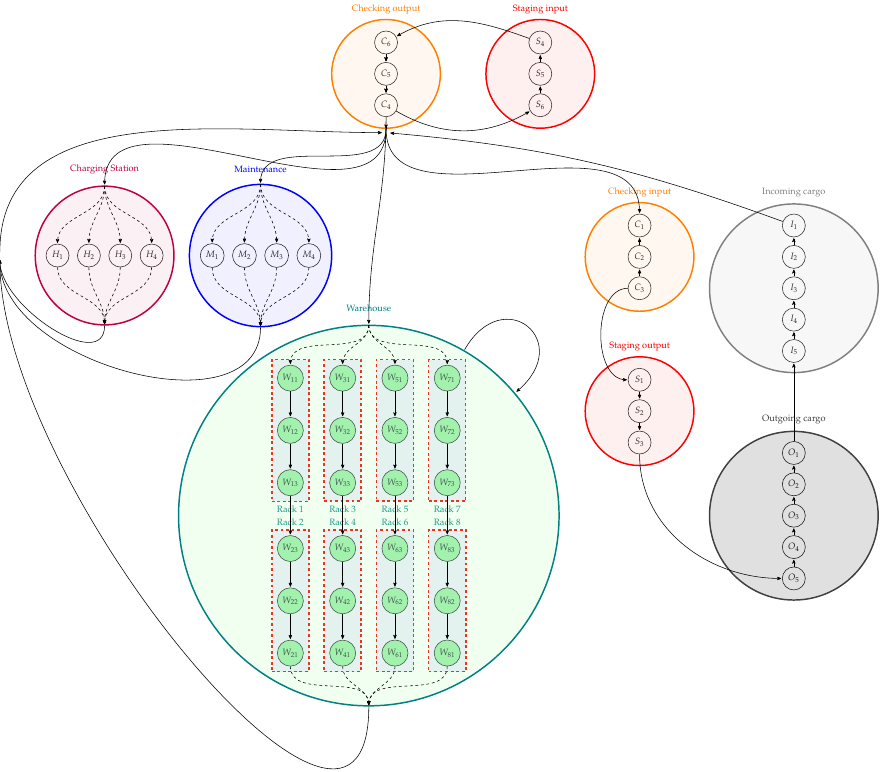
Figure 3. State machine of warehouse logistic